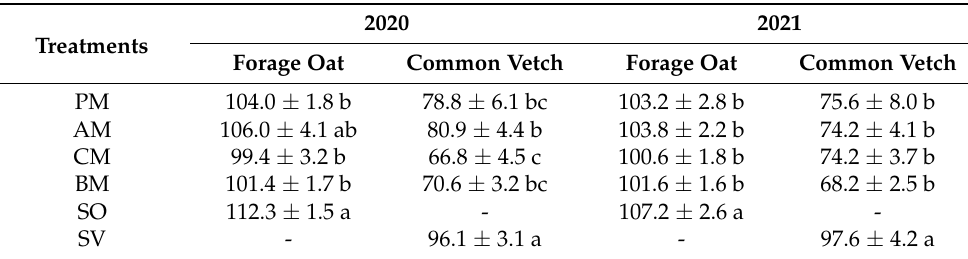
Table 3. Plant height (cm) of forage oat and common vetch among different cropping systems over two years in Yanchi county, Ningxia,